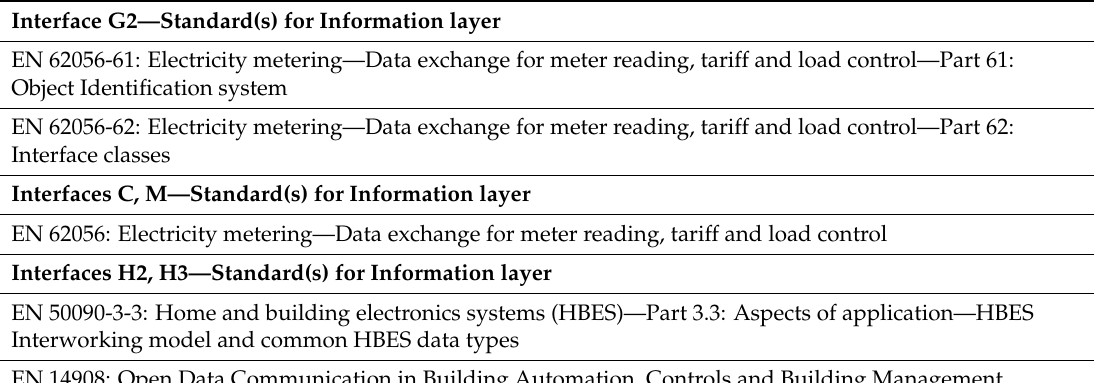
Table 3. Interfaces and standards for the information layer.